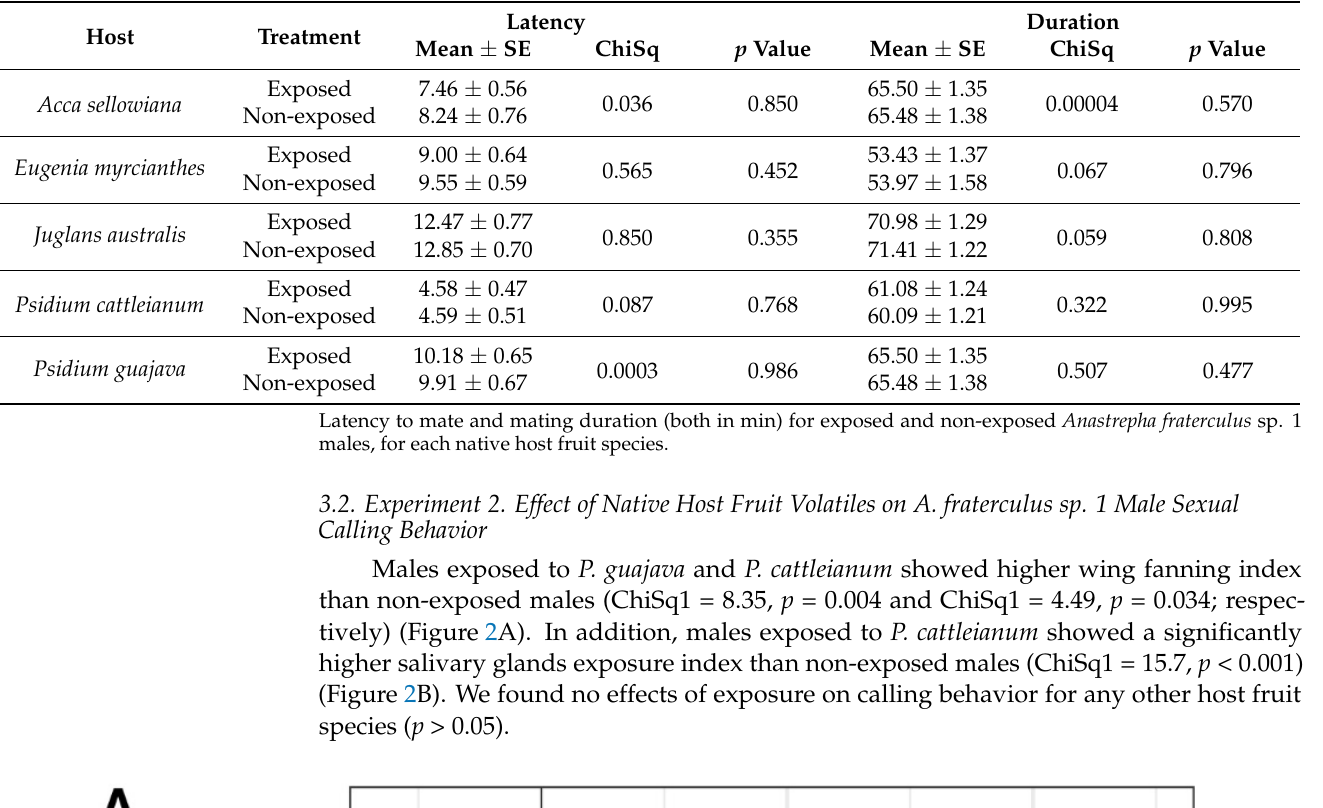
Table 2. Latency to mate and mating duration.